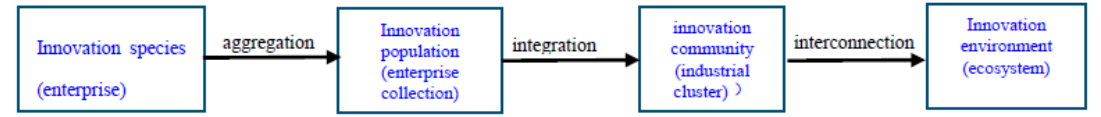
Figure 1. The evolution path of the innovation ecosystem in the high-tech zone.